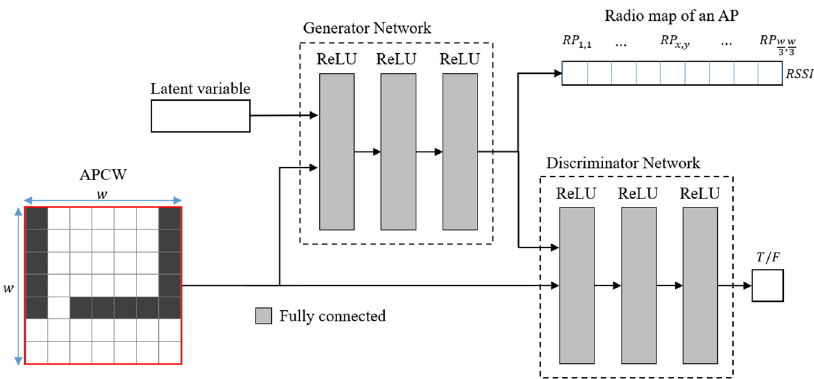
Figure 6. Structure of APCW-based RGN.